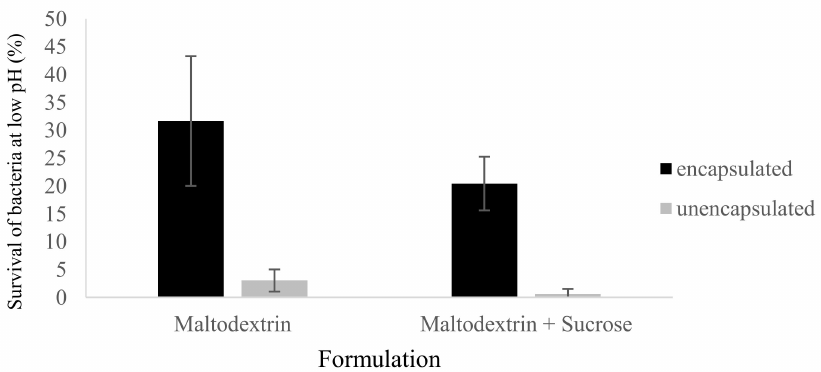
Figure 4. Survival of unencapsulated and encapsulated bacteria after 1 h at pH 2. Values shown are means ± standards deviations. Note that the encapsulated formulations indicated with ‘Maltodextrin’ and ‘Maltodextrin + Sucrose’ are also referred to as DM and DMS,